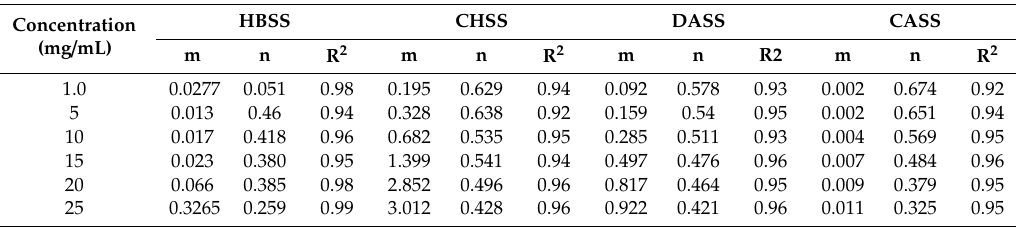
Table 1. Exponent n and coefficient m of η = m × γ × n − 1 as a function of concentration for MLPs in water at 20 °C.